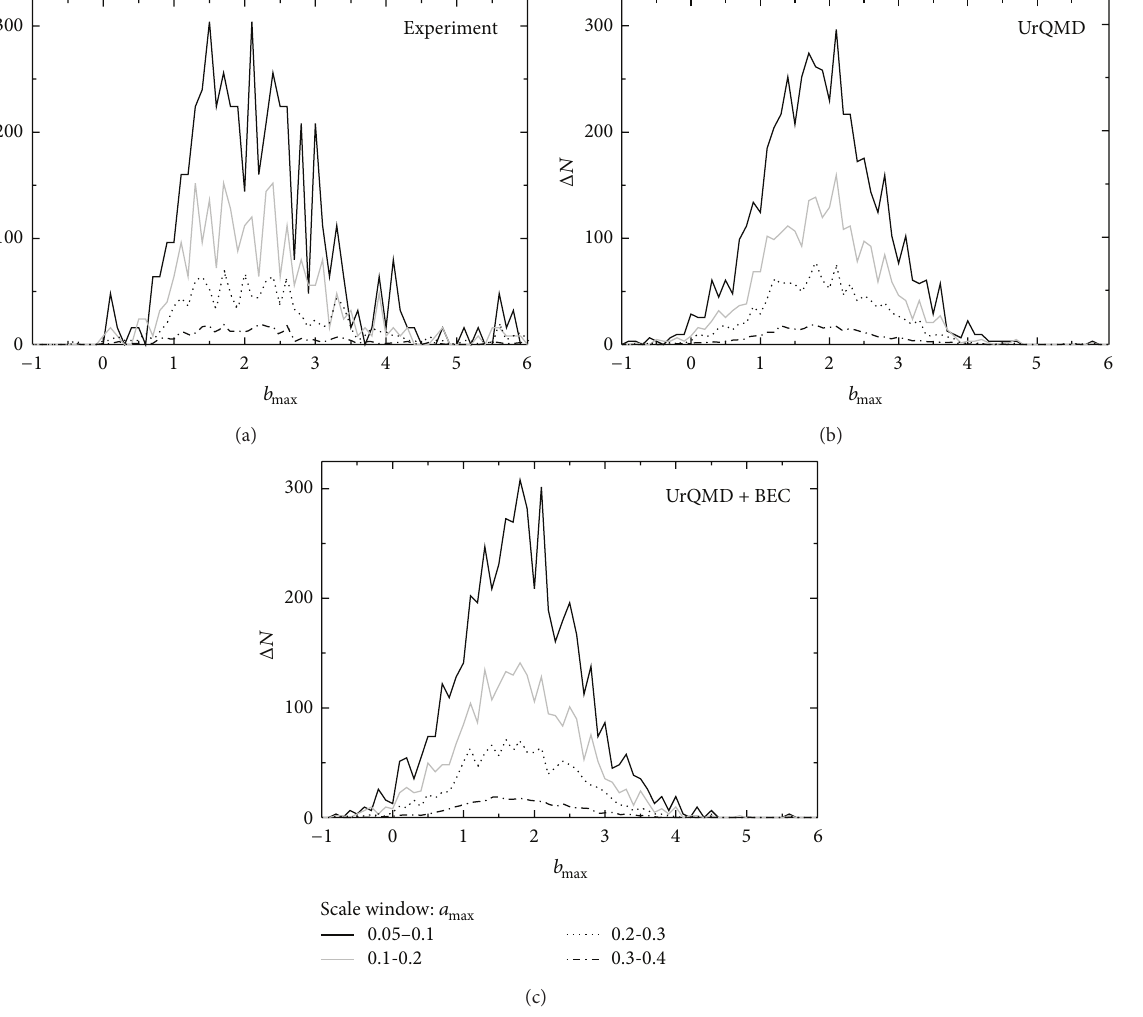
Figure 10: 𝑏 max distributions for different scale windows in 28 Si-Ag/Br interaction at 14.5AGeV—(a) the experiment, (b) the UrQMD, and (c) the UrQMD + BEC. The distributions for different scale windows are so shifted as to avoid mutual